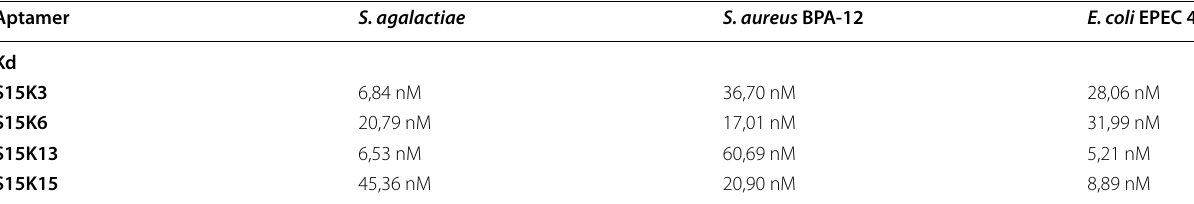
Table 3 The binding affinity of the selected aptamers